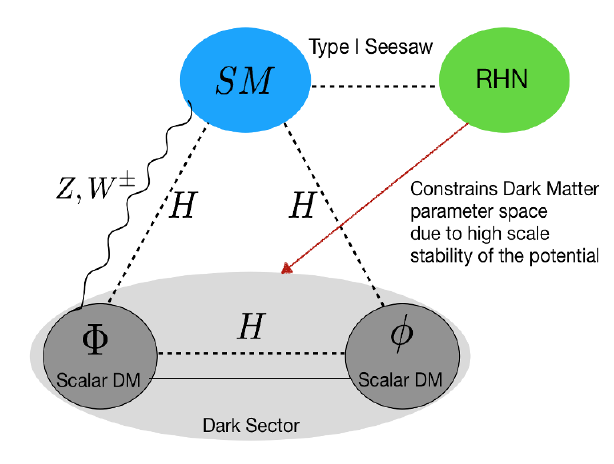
Figure 1 . A schematic diagram illustrating the di(cid:11)erent sectors of the model and their connection to SM. The dotted lines represent Higgs portal coupling, wavy line indicate gauge coupling, while the thin solid line indicates direct DM-DM coupling through (cid:21) c